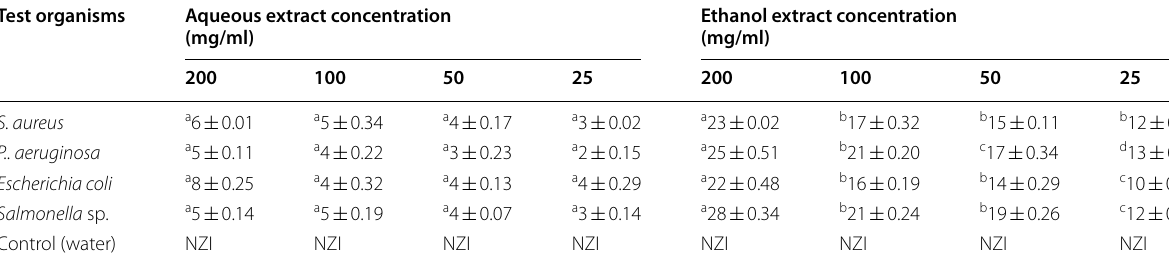
Table 5 Antibacterial activity of Moringa oleifera extracts on bacterial isolates Test organisms